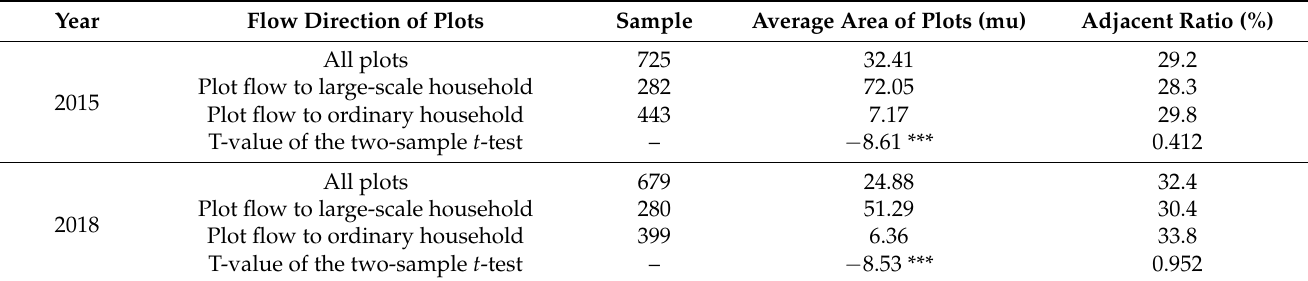
Table 4. Heterogeneity test of spatial characteristics of plots with different flow